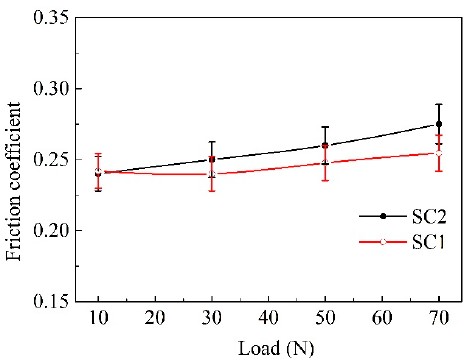
Figure 5. Average friction coeffici e nt of the sliding couple at different loads (speed = 7 mm/s).